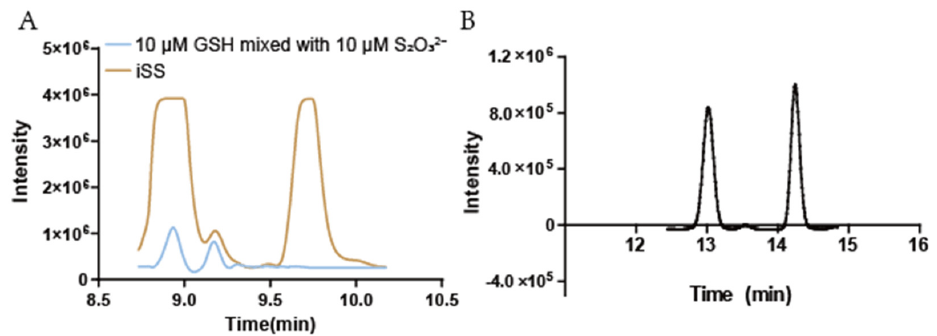
Figure 1. Partial HPLC chromatograms with two programs. The E. coli BL21(DE3) was cultured until the OD 600 reached around 1.0. The cells equivalent to 3 mL at OD 600 = 1 were collected and the iSS contents were determined with the SdSS method. After derivation with mBBr, the derivatives were determined with two different HPLC programs. ( A ) The previous used HPLC elution. The bimane- S 2 O 32 − (at 9.2 min) formed a peak overlapped with bimane-GSH (at 8.9 min). The blue curve was the mixture of 10 µ M bimane-S 2 O 3 2 − and 10 µ M bimane-GSH, which was routinely used as standard. The yellow curve was the mBBr-derivatives of an E. coli cell lysate. The large peak of bimane-GSH from the cell lysate overlapped with that of bimane-S 2 O 3 2 − . ( B ) The optimized HPLC elution. The optimized elution separated bimane-GSH (at 10.5 min, not shown) and bimane-S 2 O 3 2 − (at 13.0